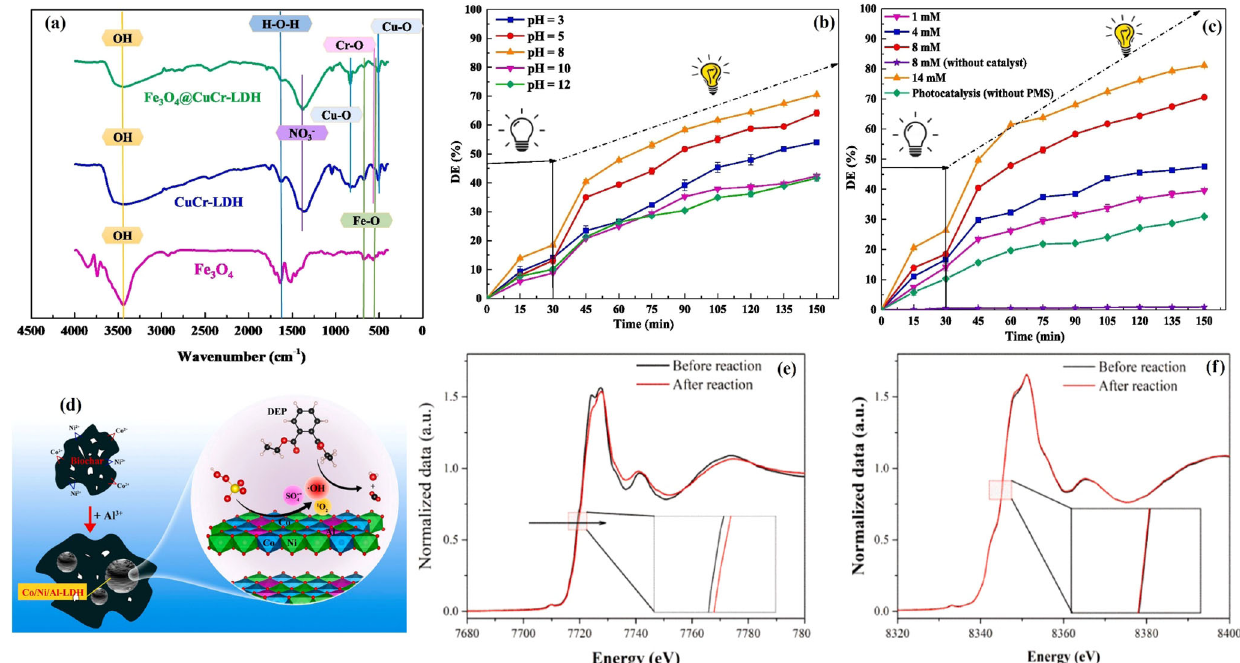
Fig. 2 Characterization of the chemical structure of LDHs-based composites and their participated metal in the PMS activation. a Fourier transform infrared (FTIR) spectra, b Effect of pH and c Effect of PMS concentration on the degradation ef fi ciency of DEP adapted with permission from ref. 100 , Copyright, 2021, Elsevier. d The schematic diagram of the PMS activation by BC-LDH for the removal of DEP, e Normalized Co K-edge, and f Ni K-edge X-ray absorption near edge structure (XANES) spectra of BC-LDH adapted with permission from ref. 105 , Copyright, 2022,